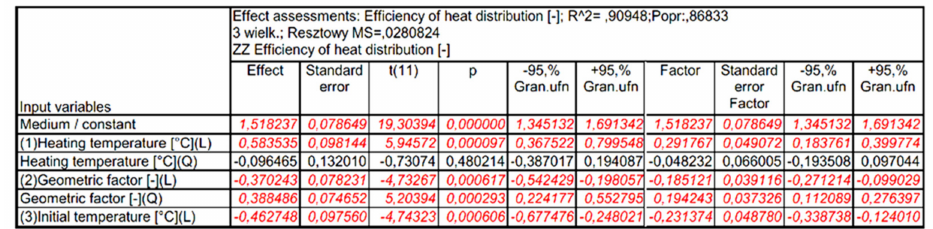
Figure 19. Summary of independent variables assessments on the output quantity, excluding insignif- icant quantities.